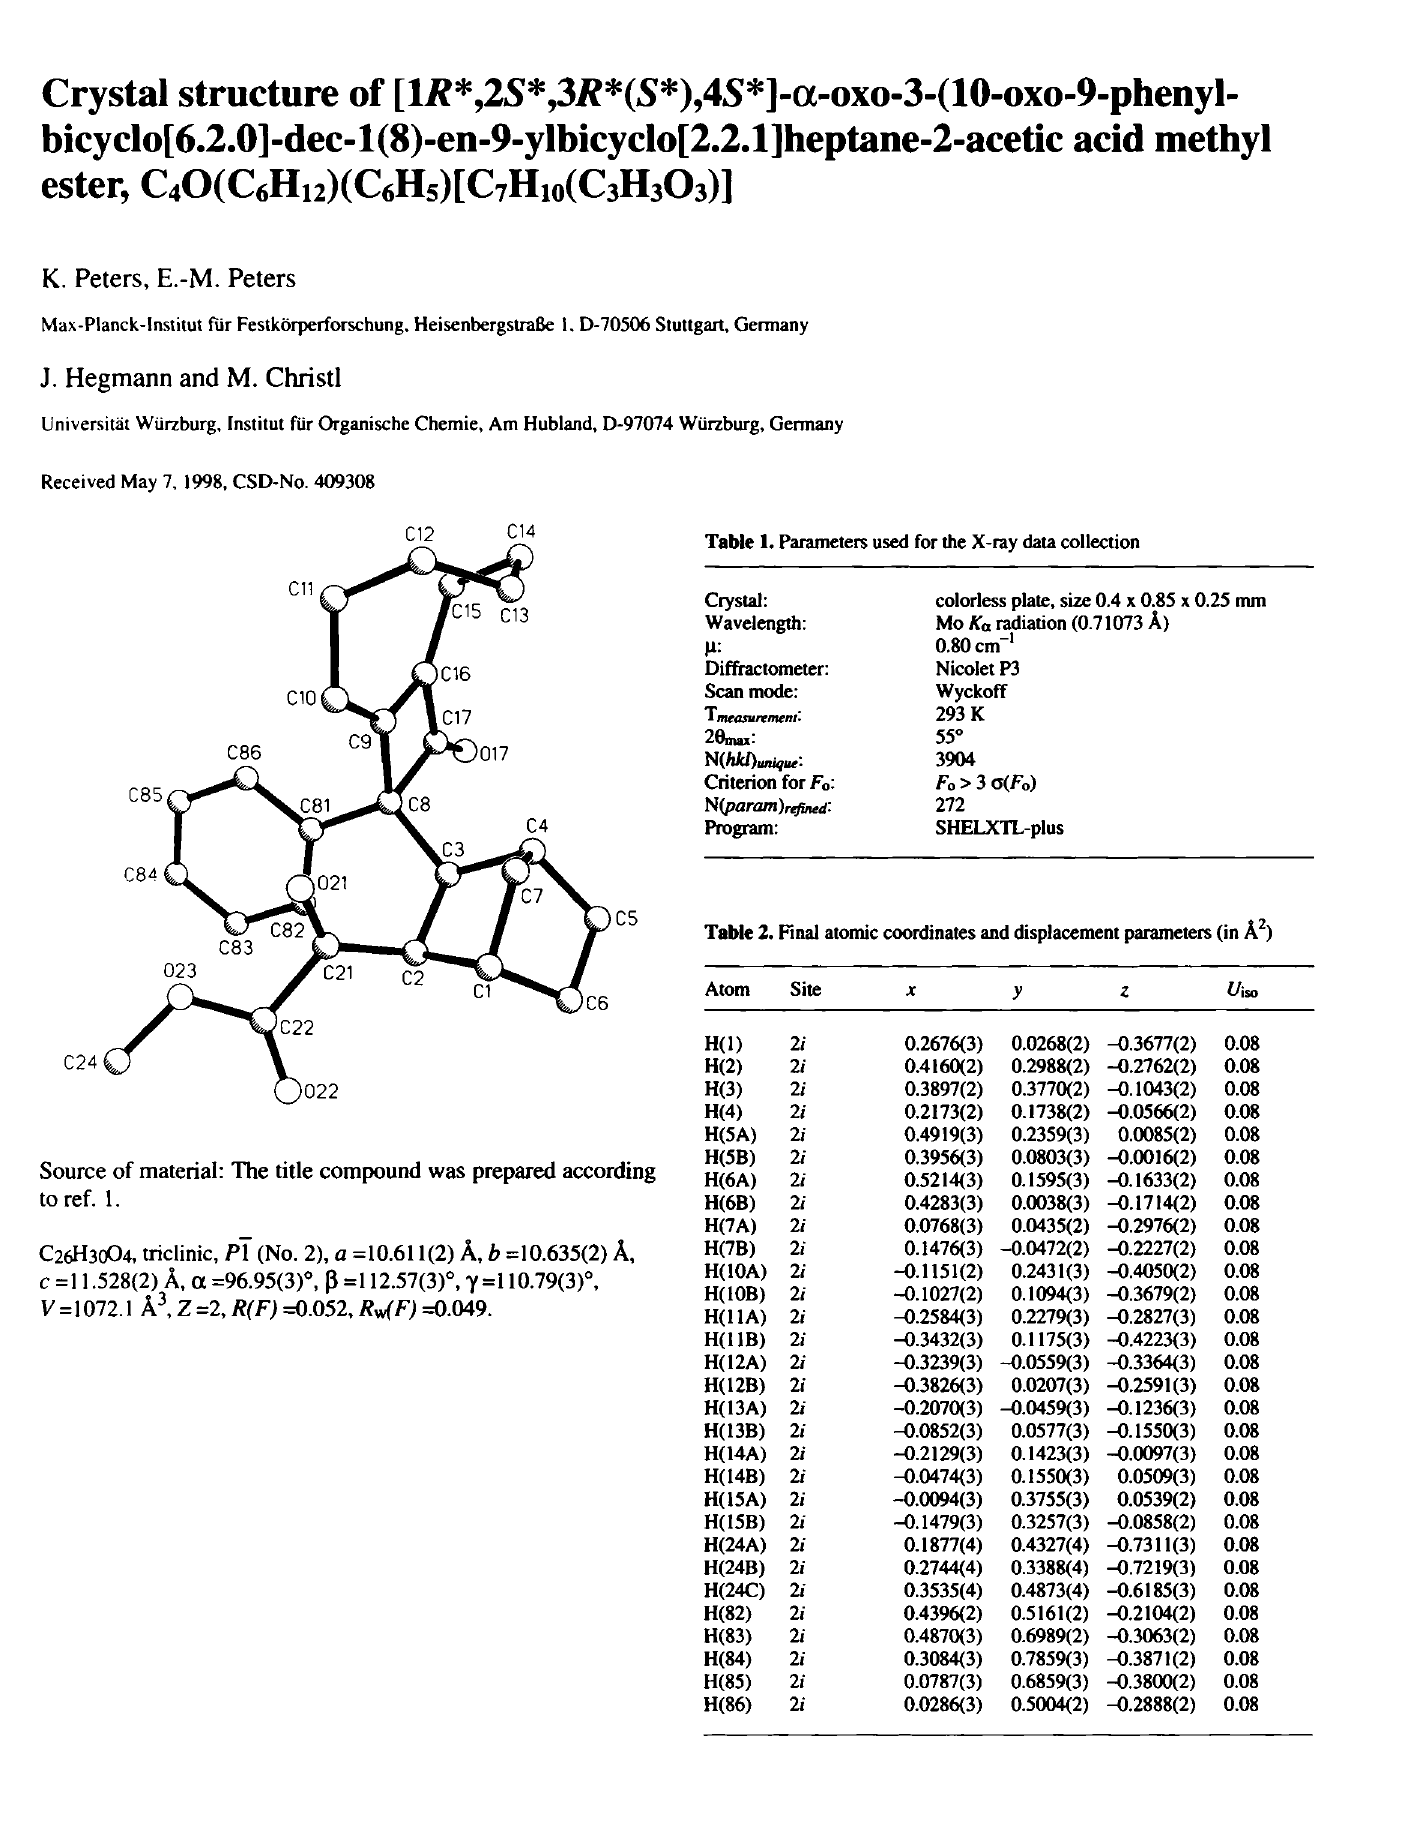
Table 1. Parameters used for the X-ray data collection